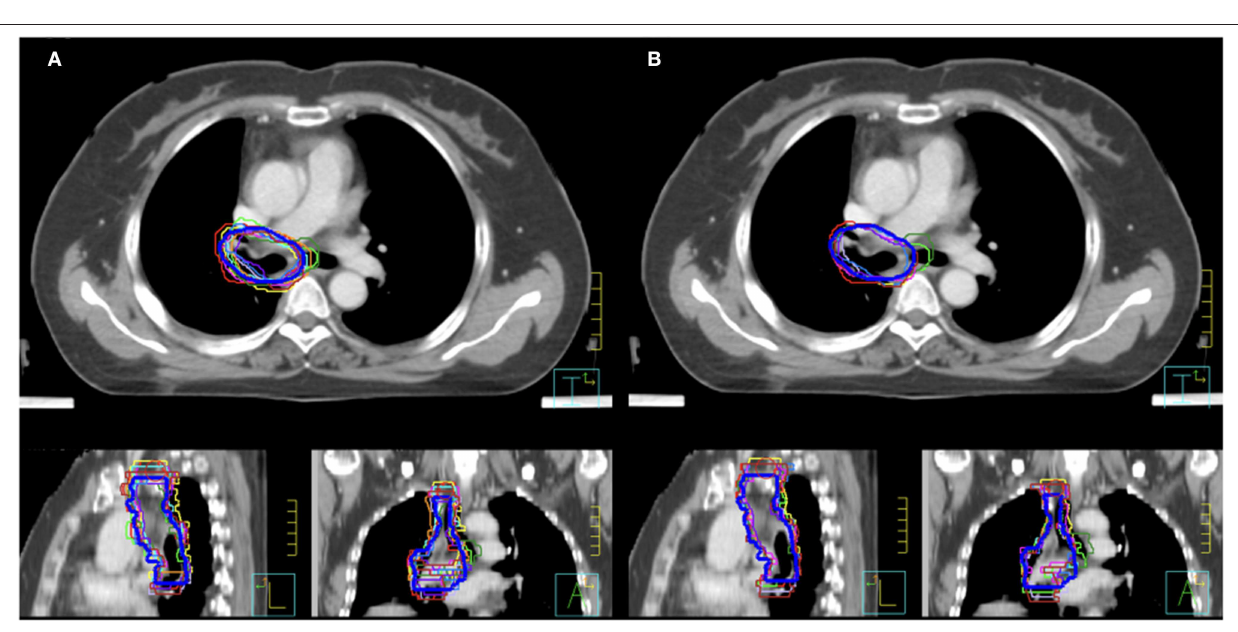
FIGURE 2 | Clinical target volume delineated by the 11 junior radiation oncologists and GT contours (blue bold line) for a representative patient with an MC (A) and a DLAC (B) . DLAC, deep learning-assisted contour; MC, manual contour; GT, ground truth